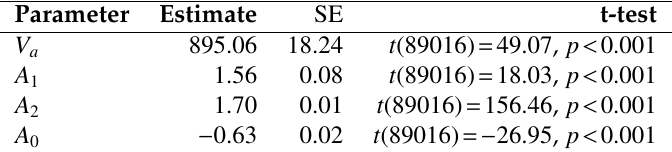
Non-linear regression coefficients and their significance tests for the inverse-linear logistic function fit to saccades .